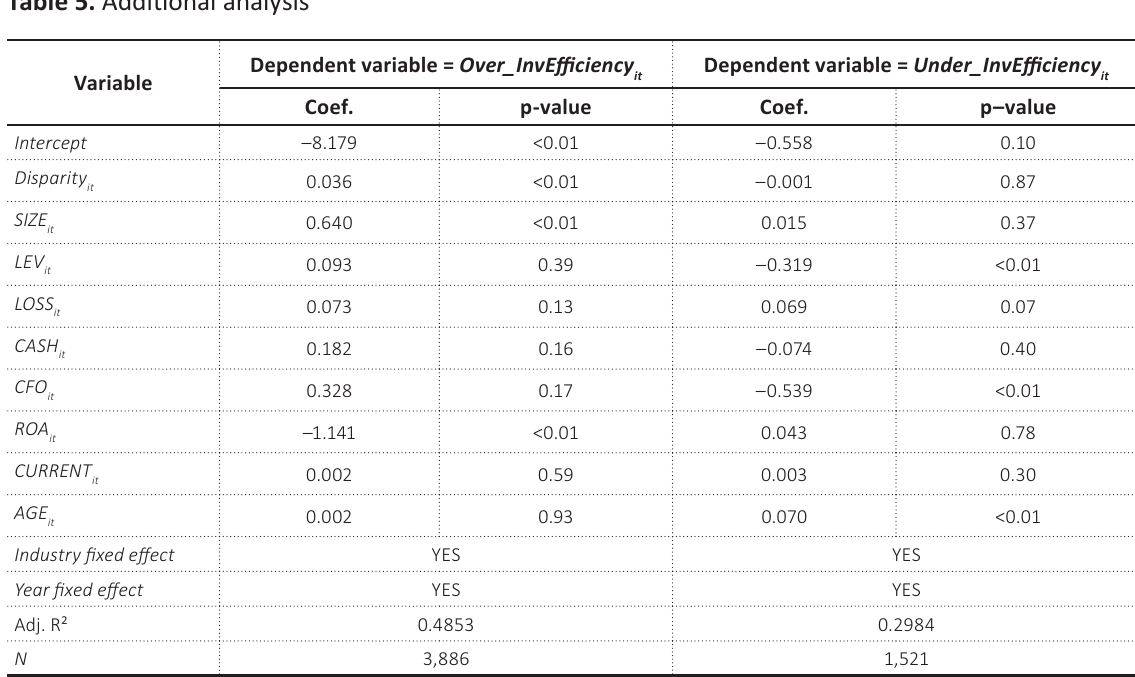
Table 5. Additional